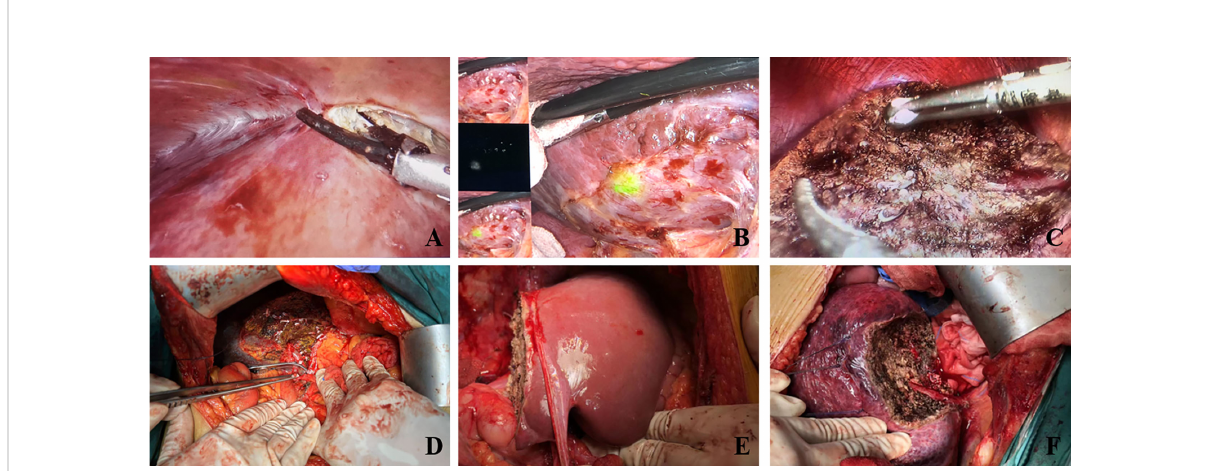
FIGURE 1 Intraoperative images of each surgical method. (A) Laparoscopic adhesiolysis for recurrent HCC. (B) Fluorescence imaging of recurrent HCC. (C) Laparoscopic left hemihepatectomy. (D) Hepatic pedicle blocked using Pringle maneuver. (E) Open right hemihepatectomy. (F) Open partial